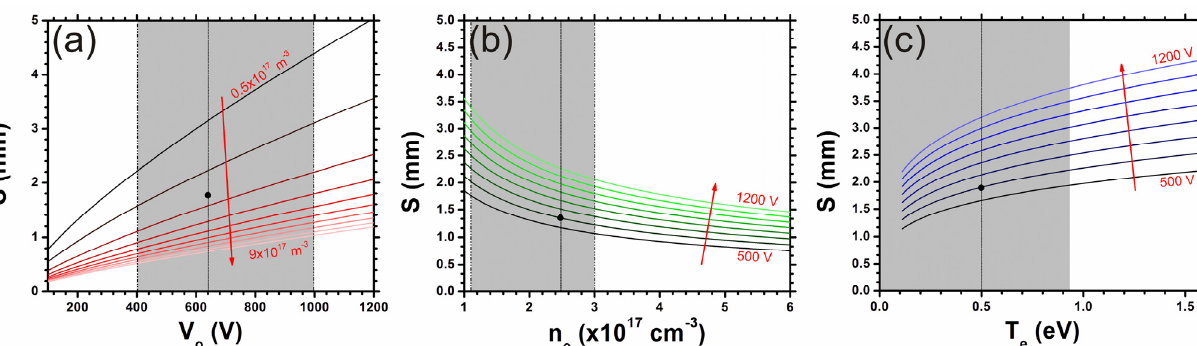
) and ( b ) electron o , with S e